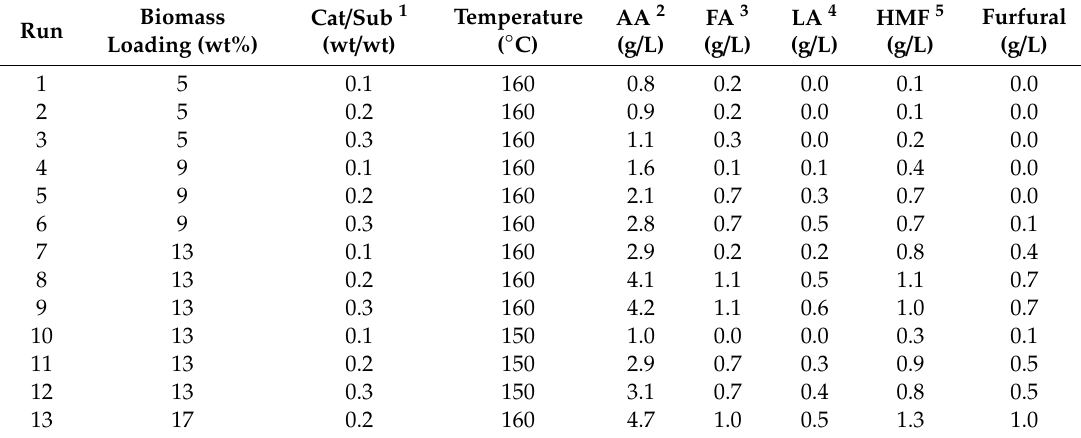
Table 4. Influence of the reaction conditions on by-product concentration formed during the hemicellulose hydrolysis. Reaction conditions: MW heating, 20